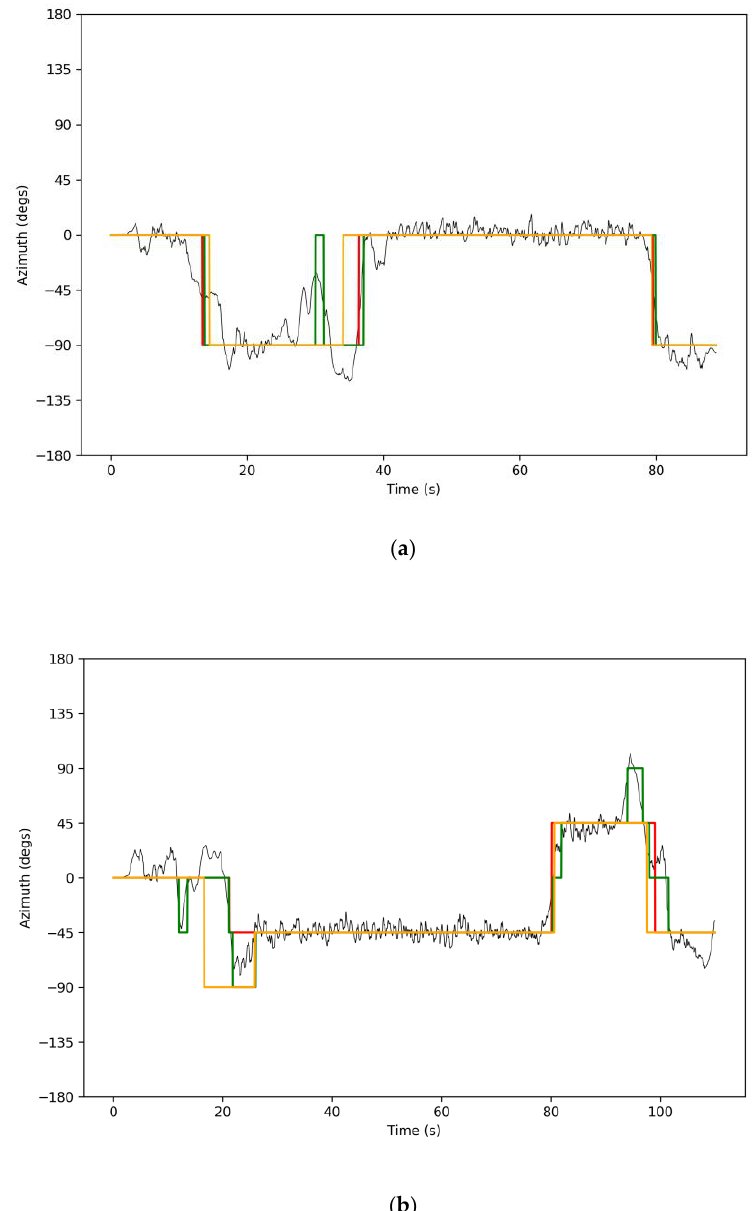
Figure 4. Example of two-stage turn detection. Black line: azimuth signal. Green line: walker’s discrete orientation as tracked by MKF. Orange line: walker’s discrete orientation as obtained by integrating the turns detected by the two-stage system. Red line: ground-truth walker’s discrete orientation. The orientation resolution of the MKF was 90° ( a ) or 45° ( b ).